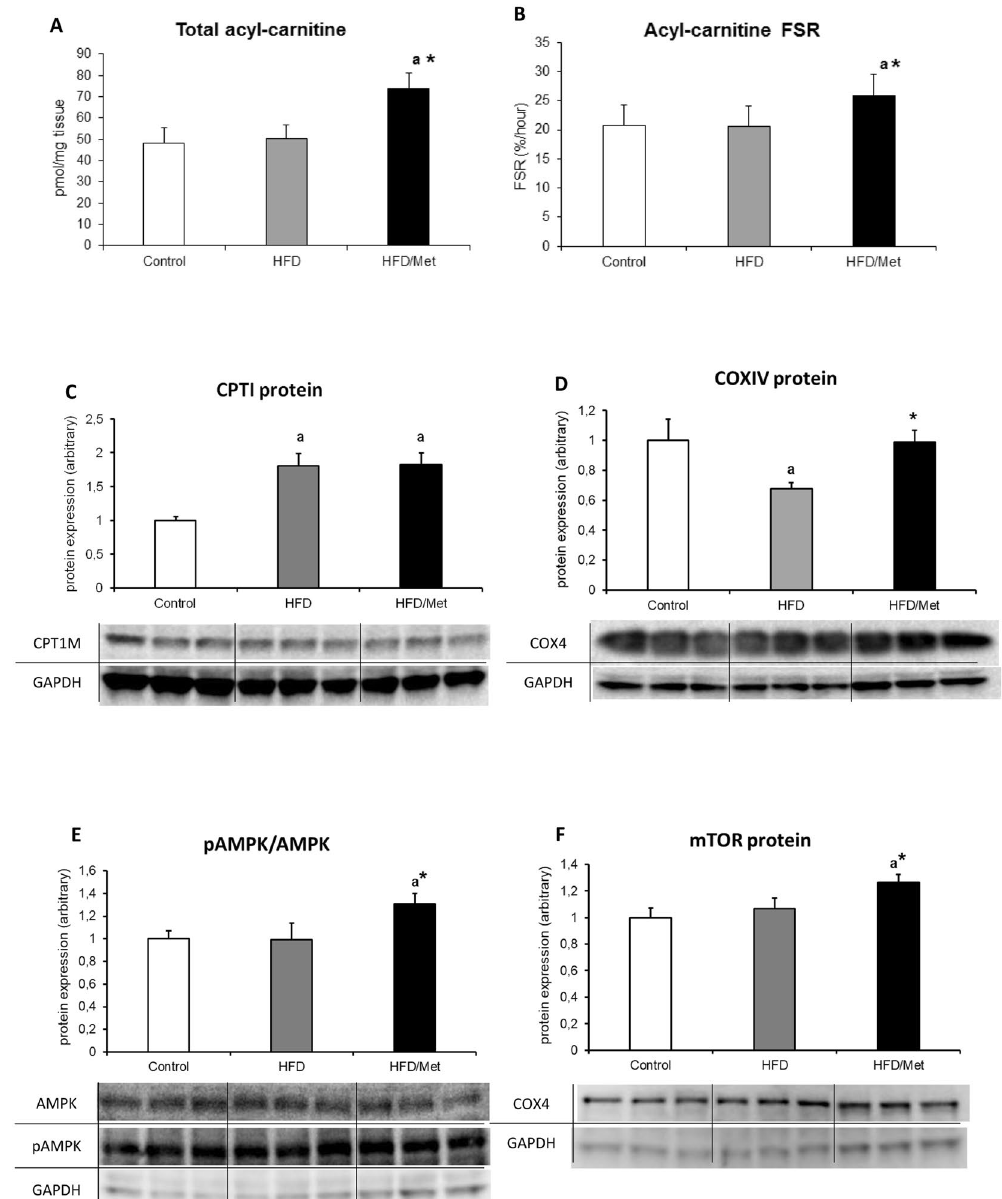
Figure 4. The impact of HFD consumption and metformin treatment on mitochondrial channeling of fatty acids and AMPK/mTOR proteins. Panel A and B present total content and synthesis rate of hepatic acyl- carnitine, respectively; Panel C and D show liver expression of carnitine palmitoyltransferase 1 (CPTI) and cytochrome c oxidase subunit IV (COX IV, mitochondrial marker); Panels E and F present phosphorylation state of AMPK and the protein expression of mTOR. Values are mean + / − SD. Symbols denote statistical significance of p < 0.05 versus: a- vs. Control group; * - vs. HFD group. n = 8 per group; Significance by Anova with Tukey HSD post-hoc